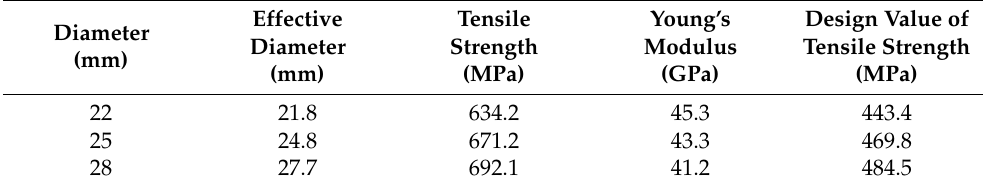
Table 2. Mechanical parameters of GFRP in different diameters.